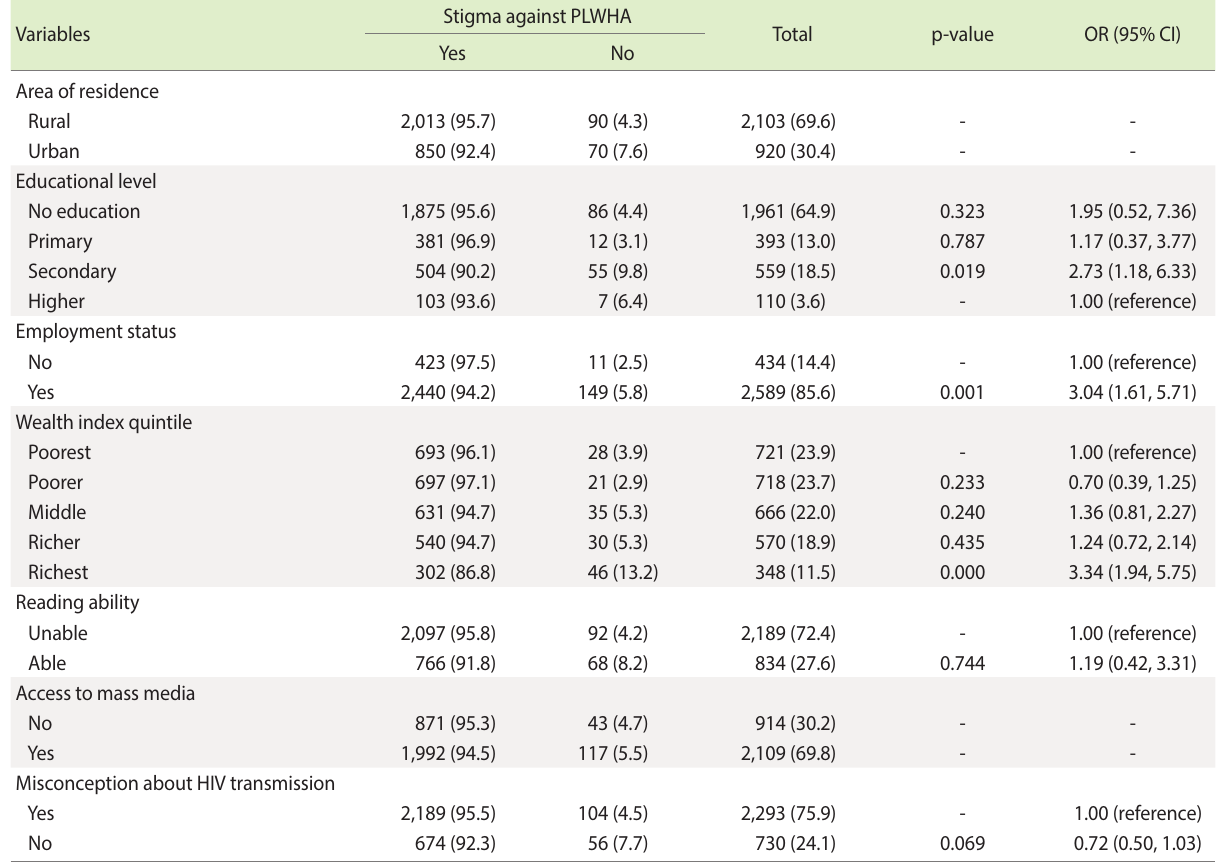
Table 3. Descriptive statistics and multivariable regression model exploring variation in stigma against PLWHA